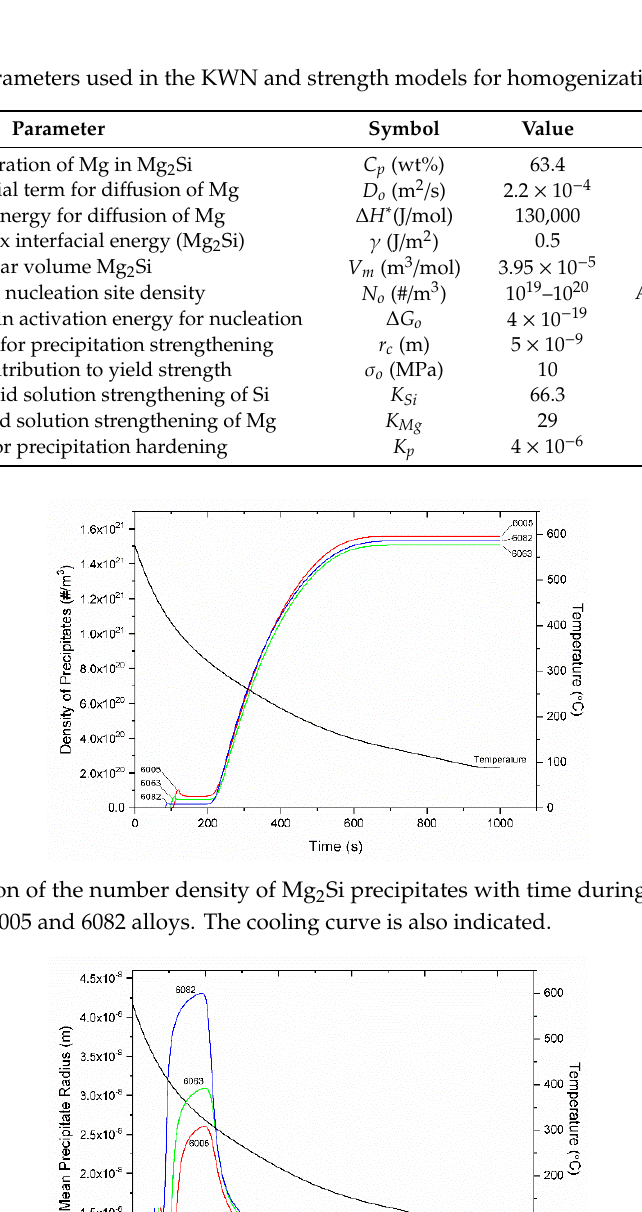
Table 4. Parameters used in the KWN and strength models for homogenization cooling.